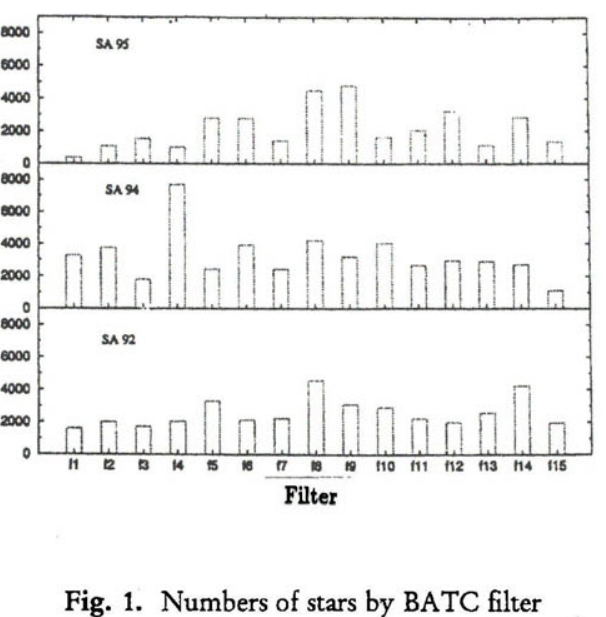
Fig. 1. Numbers of stars by BATC